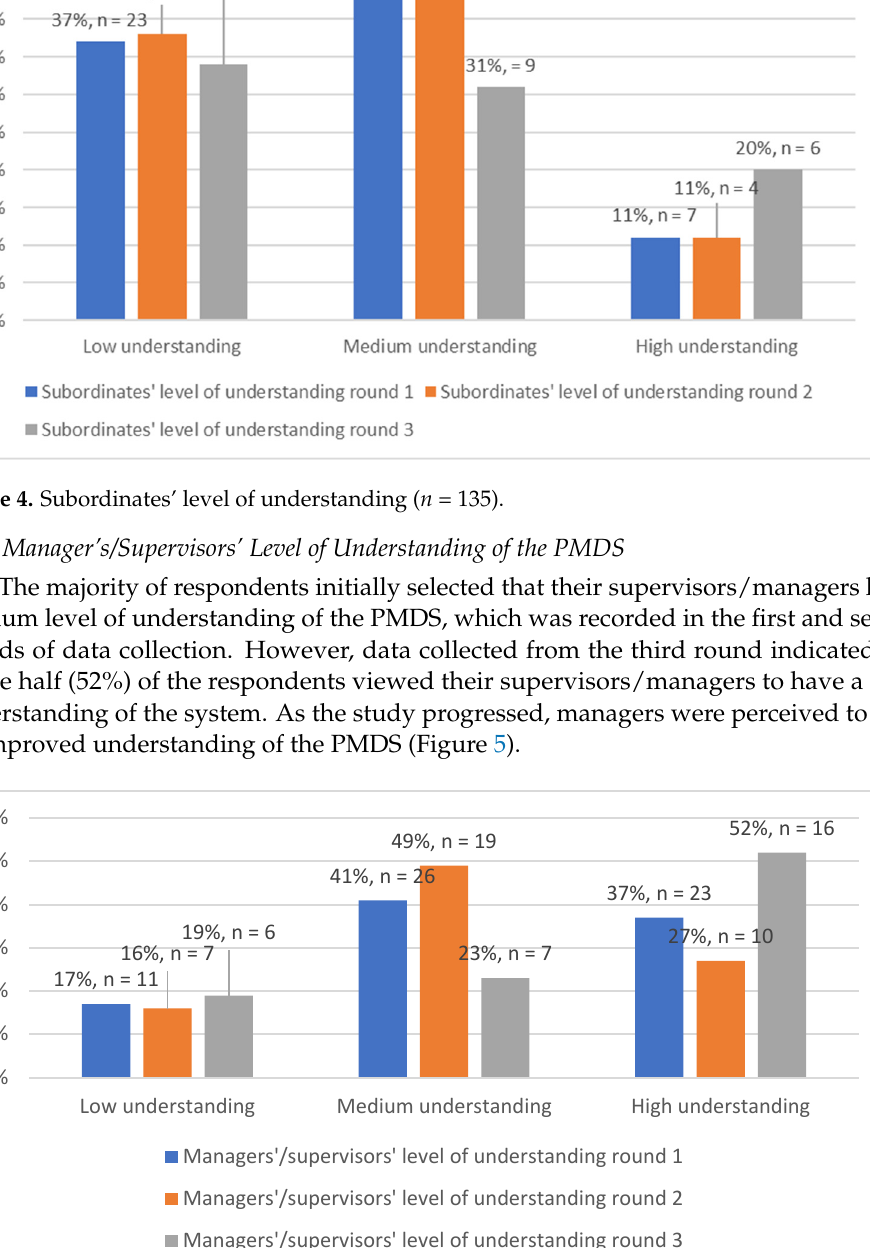
Figure 3. Personal level of understanding of the PMDS ( n = 135).